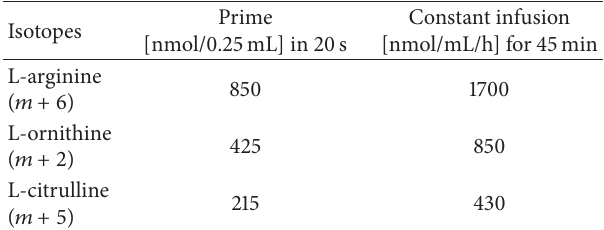
Table 1: Isotope concentrations used for primed constant